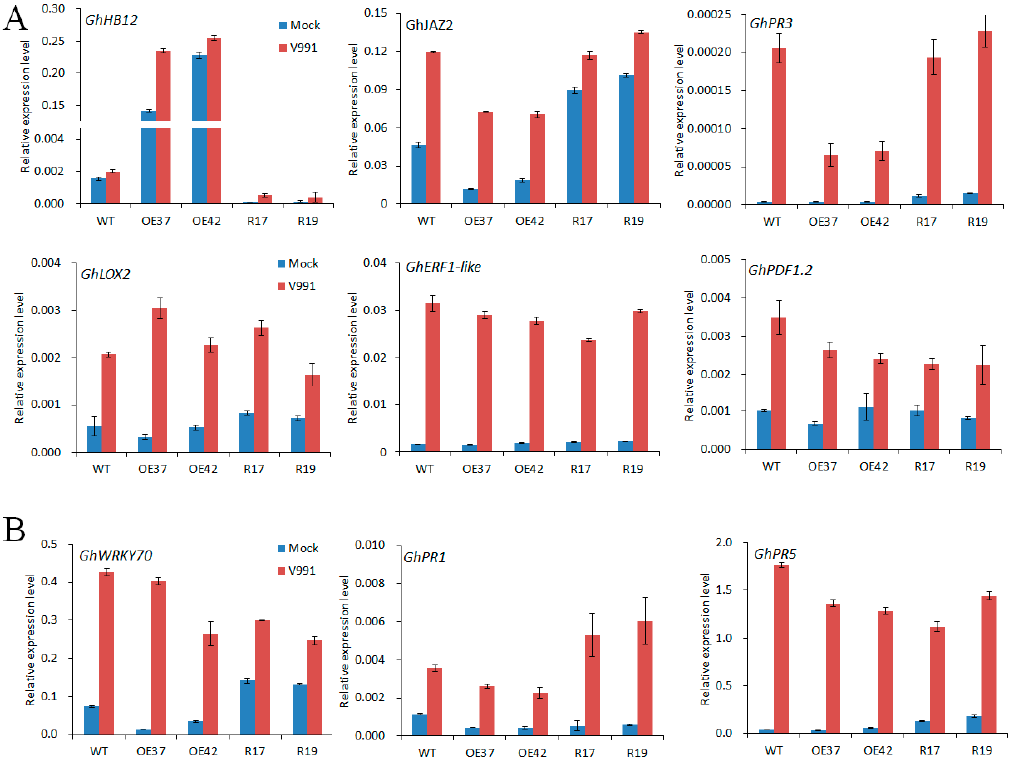
Figure 6. GhHB12 reduced the expression of jasmonic acid (JA)-responsive defense maker genes ( GhJAZ2 , GhPR3 ) in cotton. qRT-PCR analysis of ( A ) JA-responsive defense maker genes and ( B ) SA-responsive defense maker genes in roots of wild-type (WT) and GhHB12 transgenic cotton lines (overexpression lines: OE37 and OE42; RNAi lines: R17 and R19) after inoculation with or without V. dahliae V991. Total RNAs were extracted from roots of seedlings at the indicated time points (24 h) after 12 h inoculation. The GhUBQ7 gene was used as the endogenous reference gene. The data represent the mean ± SD of three technical replicates.